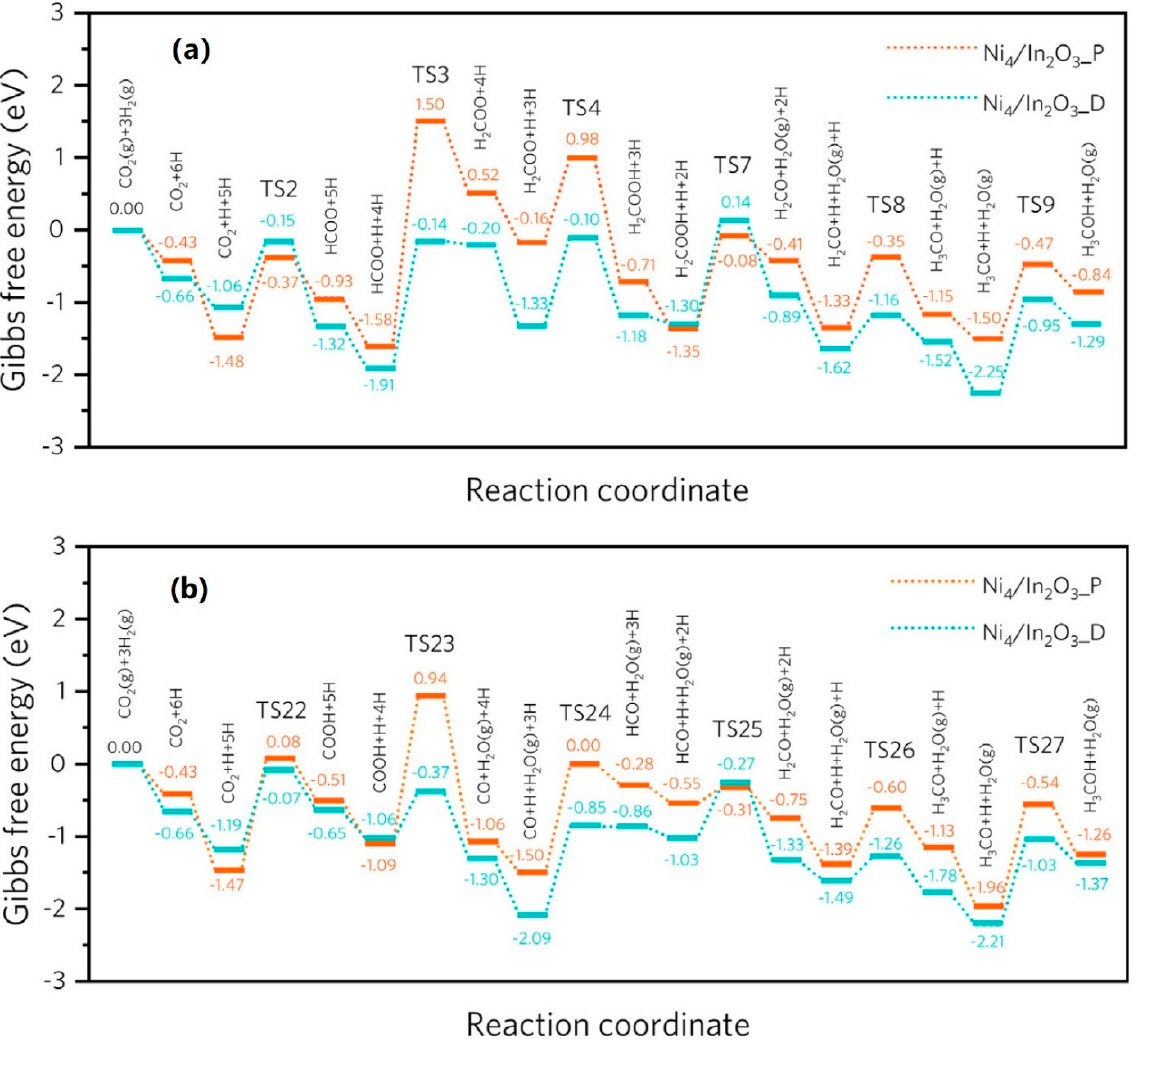
Figure 11. Gibbs energy profiles for CO 2 hydrogenation to methanol over Ni 4 /In 2 O 3 via the ( a ) for- mate pathway and ( b ) RWGS pathway. The orange line and blue line represent the Ni 4 /In 2 O 3 _P and Ni 4 /In 2 O 3 _D, respectively. Reprinted with permission from ref. [258]. Copyright 2022 Elsevier.